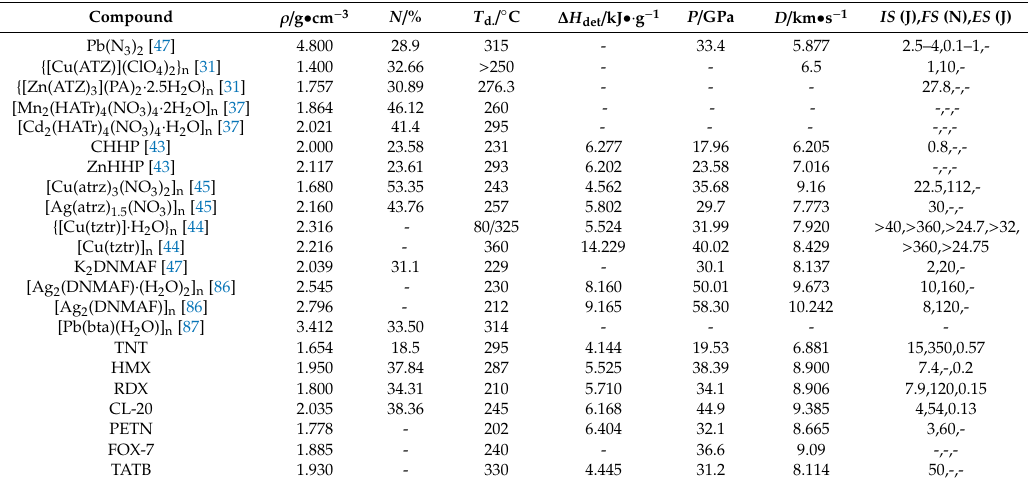
Table 1. Physicochemical and energetic properties of some EMOF materials and classical explosives.